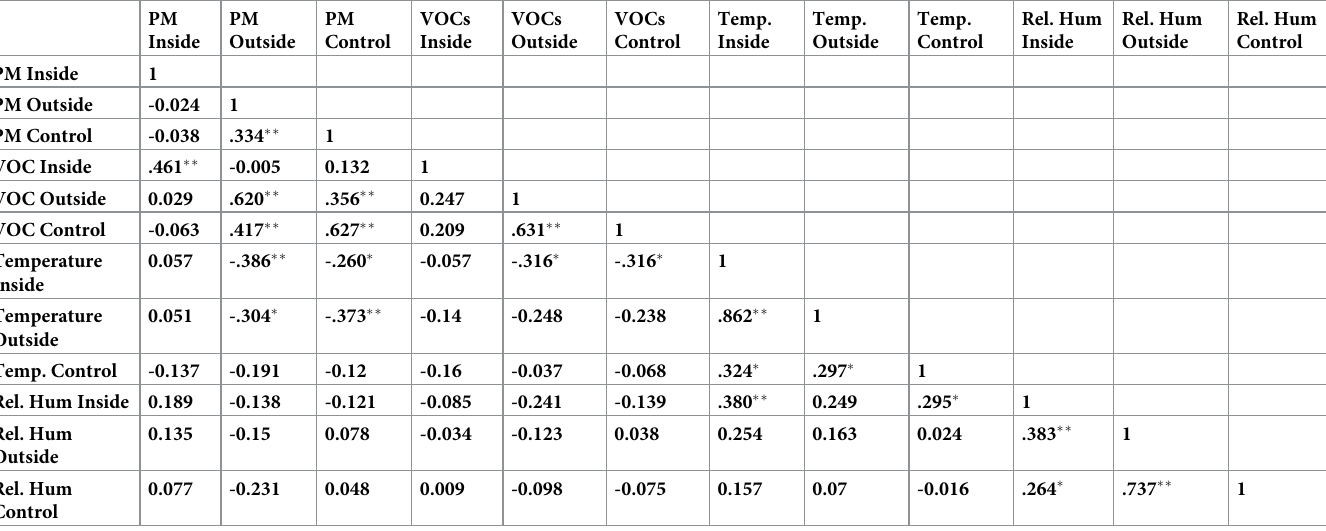
Table 2. Correlation matrix of environmental variables